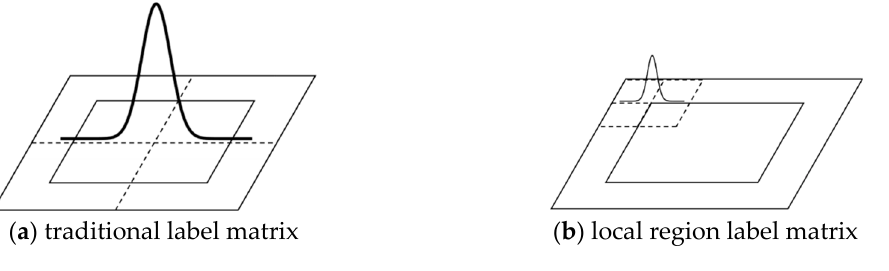
Figure 4. The comparison of label matrix between traditional circular samples and local region circular samples in time domain. The curves above the two label matrices denote the two-dimensional Gaussian distribution of both cases.